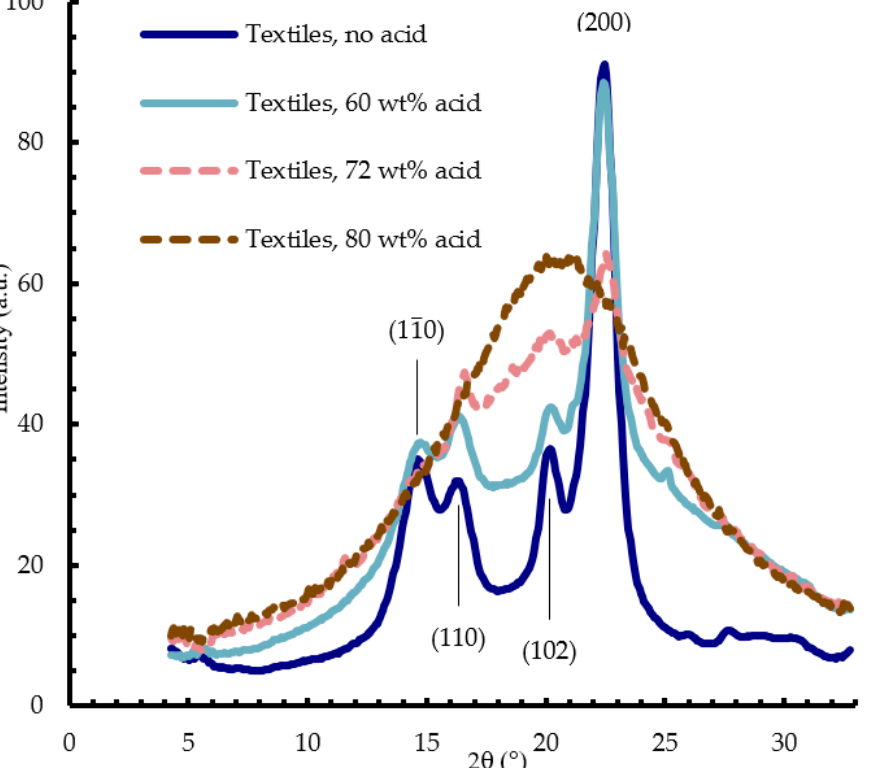
Figure 2. WAXS diffractograms measured on cotton waste textiles treated with varying concentra- tions of sulfuric acid in the pre-hydrolysis